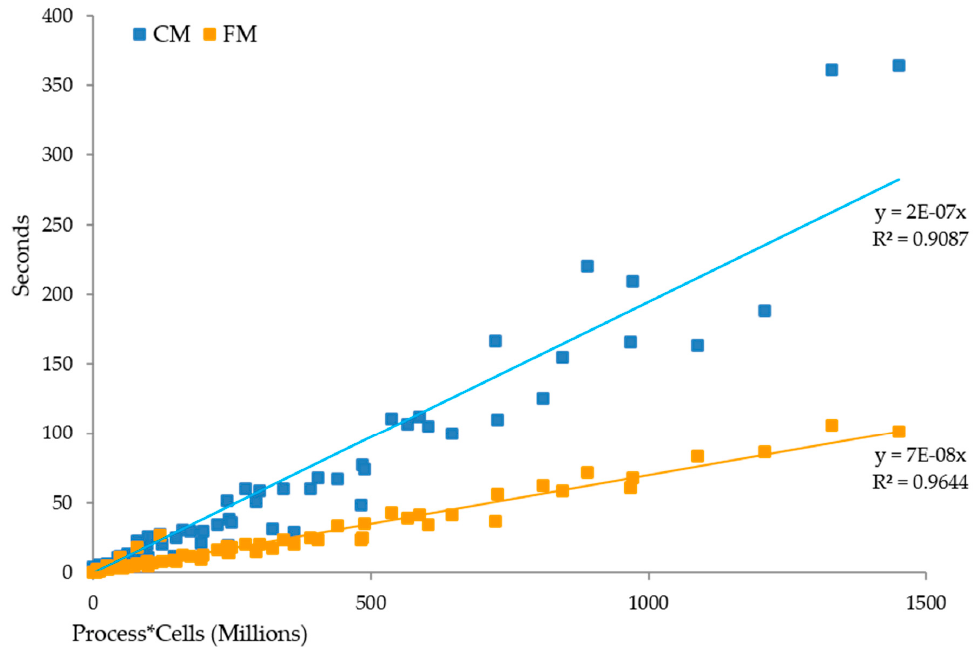
Figure 5. Conventional modeling (CM, blue) and function modeling (FM, yellow) regression results for processing time.